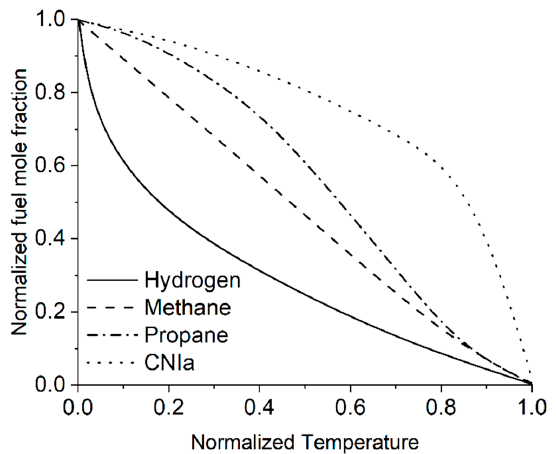
Figure 34. Distribution of normalized temperature and fuel mole fraction for four fuels with differ- ent Lewis numbers. Lewis